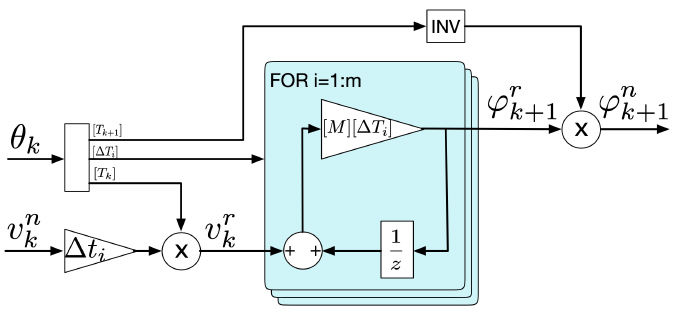
Figure 7. Discrete time model with rotor reference frame integration: